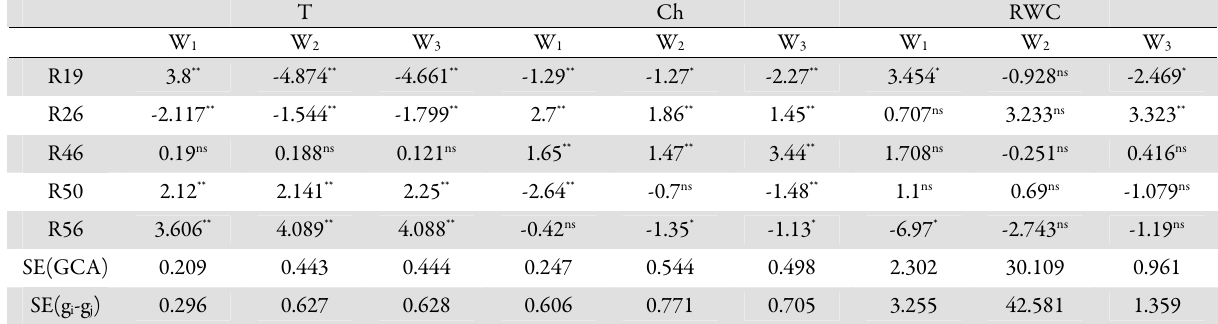
Tab. 4.1. Estimates of general combining ability of the male restorer lines for canopy temperature (T), chlorophyll fluorescence (Fvm), chlorophyll content (Ch), relative water content (RWC) at the different levels of irrigation. Normal irrigation (W 1 ), mild water stress (W 2 ), severe water stress (W 3 )